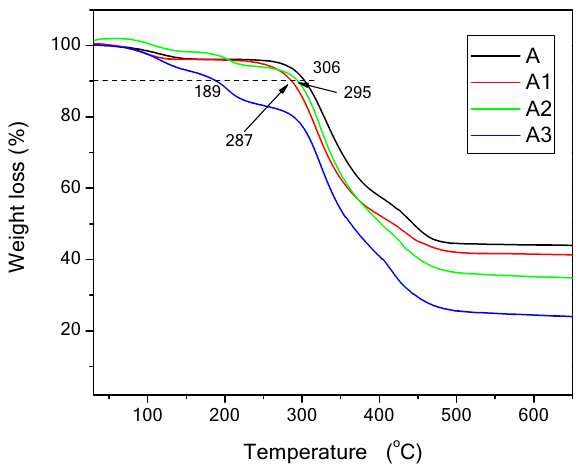
Figure 2. TGA of packaging films A1, A2, and A3 compared with pure film A.